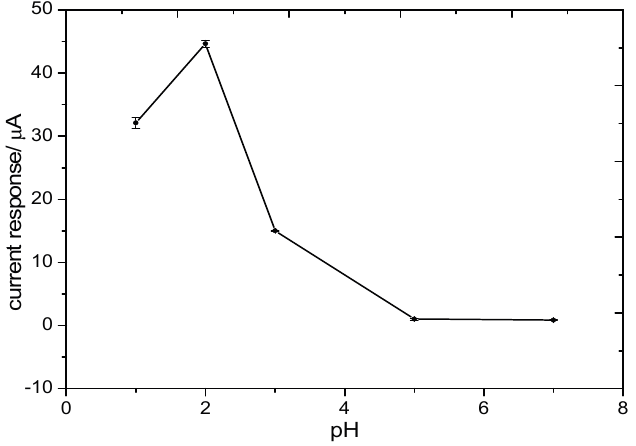
Figure 6. Current response by LSV at E = − 0.51 V (potential versus Ag/AgCl) in 5 mg/L KNO 3 (as N) and 0.01 M KClO 4 solutions with different